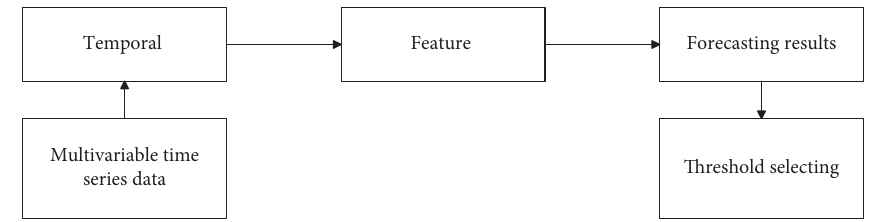
Figure 1: Overview of